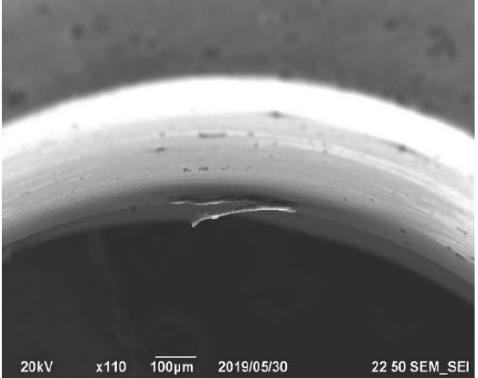
Figure 1. The nature of the burrs on the details of beryllium bronze with an increase in the cutting speed and feed: There is a strong attachment to the surface of the part along the length of the burr. When processing the experimentally selected parameters, the burrs are short and drop-shaped; the root thickness is up to 0.03 mm. With an increase in the cutting speed up to 125 m/min and feed up to 0.1 mm/rev, the burrs are long and stretching; the root thickness is up to 0.08 mm (Figure 2). The burrs on beryllium bronze workpieces are highly resilient. The burrs on workpieces made of the 29 NK alloy have a high hardness. The length and thickness of the burr root increase along with tool wear 1.5–1.7 times.